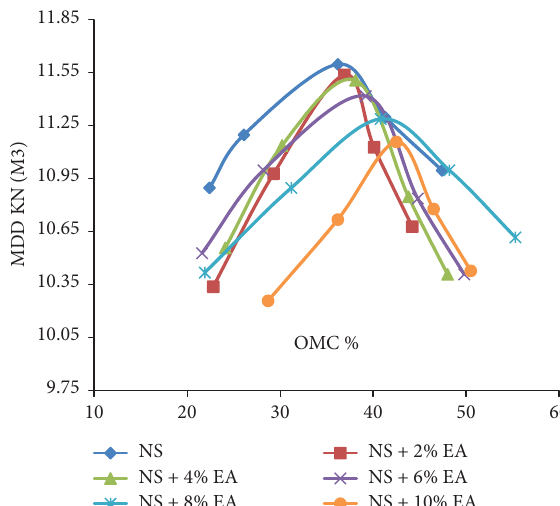
Figure 2: Compaction curve of natural soil (NS) treated with various percentages of Enset ash